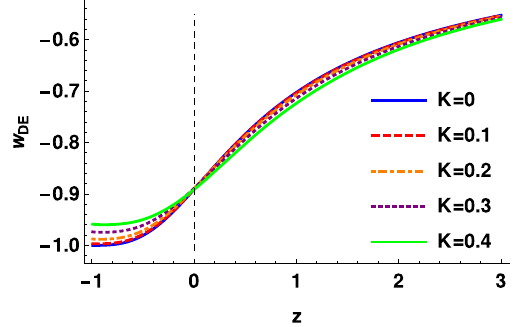
Fig. 3 The redshift-evolution of the equation-of-state parameter w DE of Kaniadakis holographic dark energy, for fixed c = 1 and various values of K . We have imposed (cid:8) DE 0 ≈ 0 . 7 we have added a vertical dotted line marking the present time z =